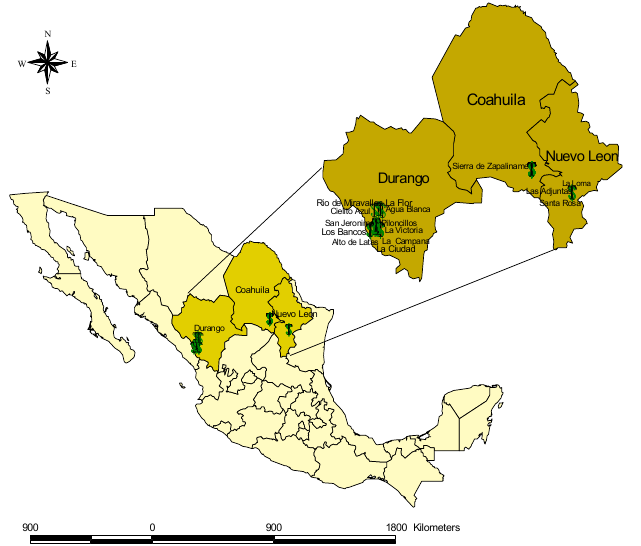
Figure 1. Location of northern Mexico non-industrial planted forest stands sampled for litter stocks.